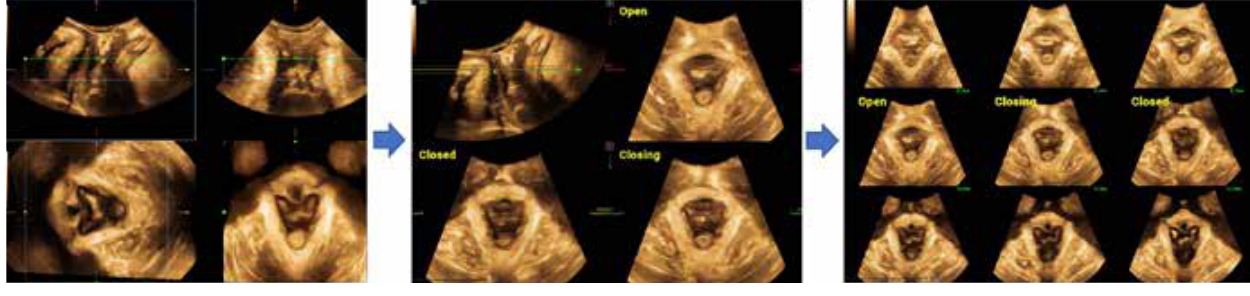
Pelvic floor volume data Automatic imaging GridView Figure 2 Automatic Tomography of LAM by Smart-pelvic.